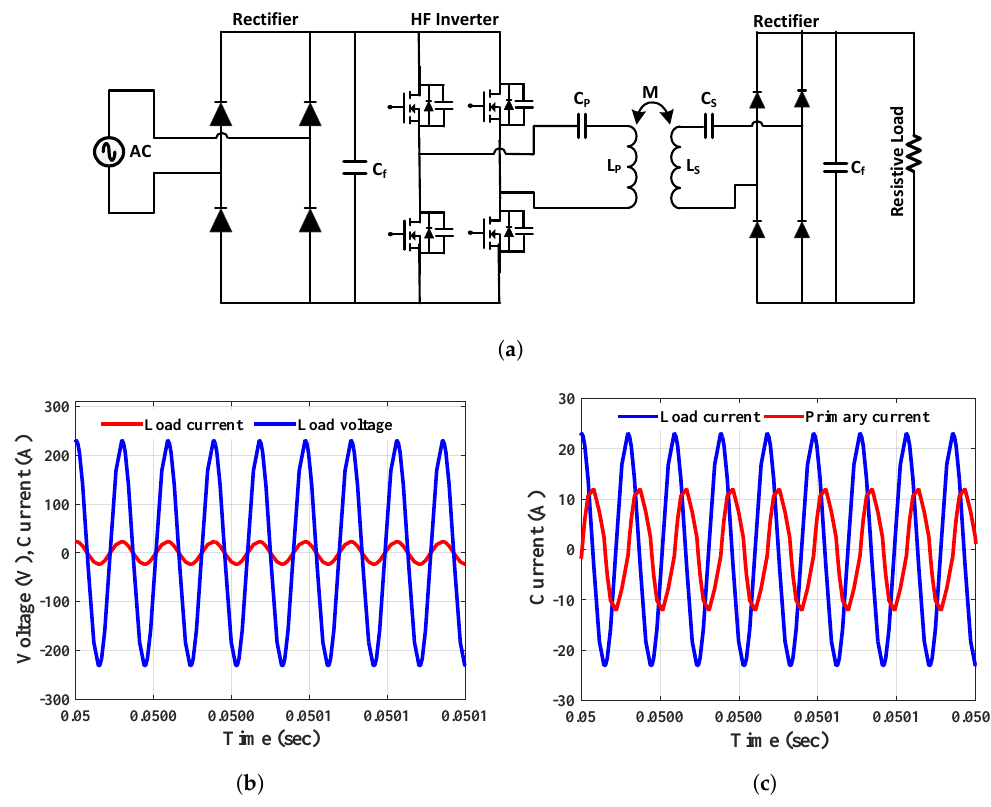
Figure 19. ( a ) SIMULINK schematic diagram; ( b ) load voltage and load current waveforms; ( c ) the secondary and primary currents waveforms.